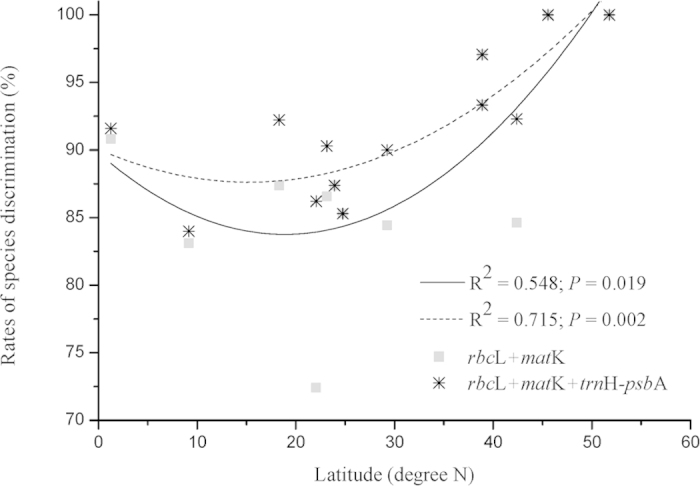
Species discrimination rates of rbcL + matK and rbcL + matK + trnH–psbA along a latitudinal gradient.